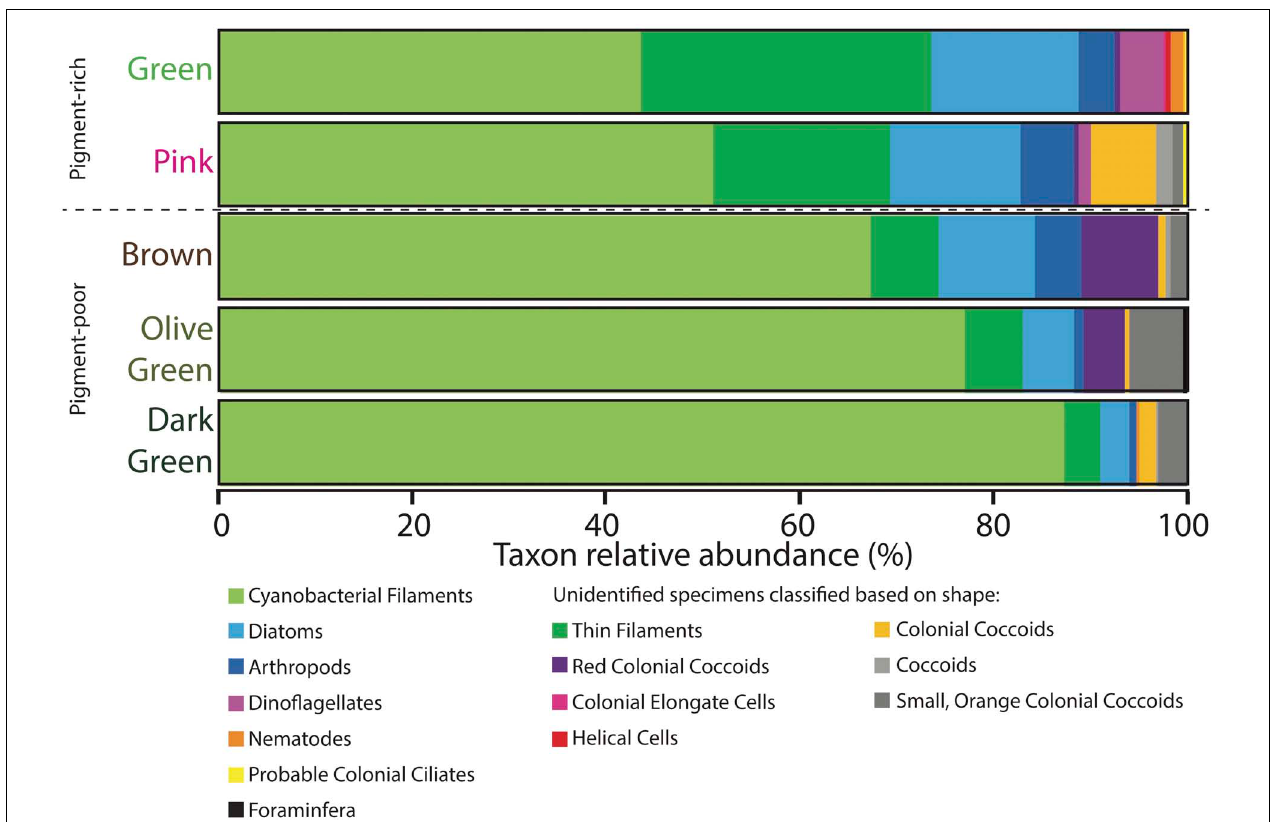
FIGURE 7 | Microbial assemblages expressed as percent taxon relative abundance from four 100-counts of specimens on strewn wet mount microscope slides via optical microscopy. Specimens observed under the microscope that could not be positively identified because of a lack of diagnostic features are classified based on shape and are listed in the two rightmost columns. Data for four 100-counts and standard deviations are provided in Supplementary Table S2